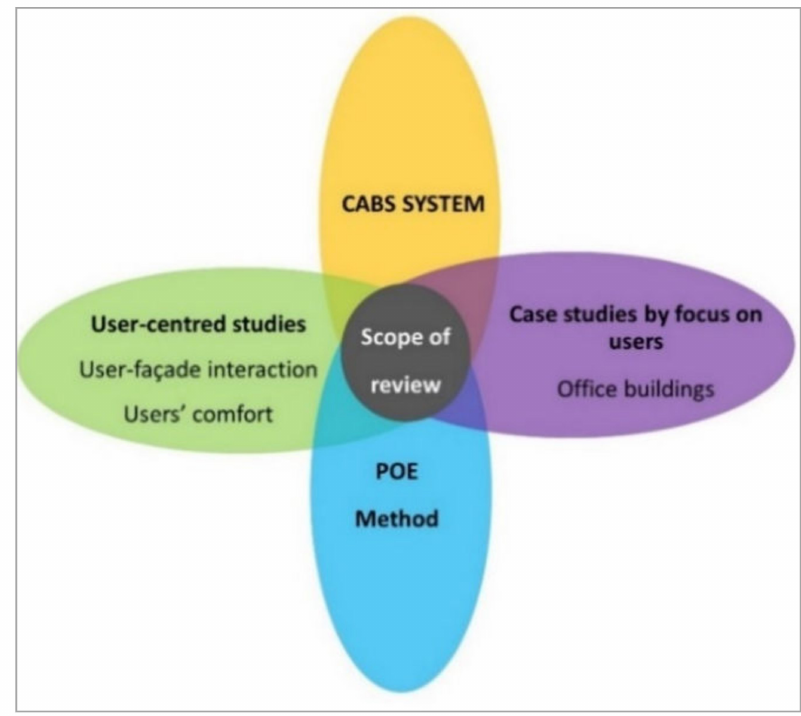
Figure 1. Scope of the study (Authors,